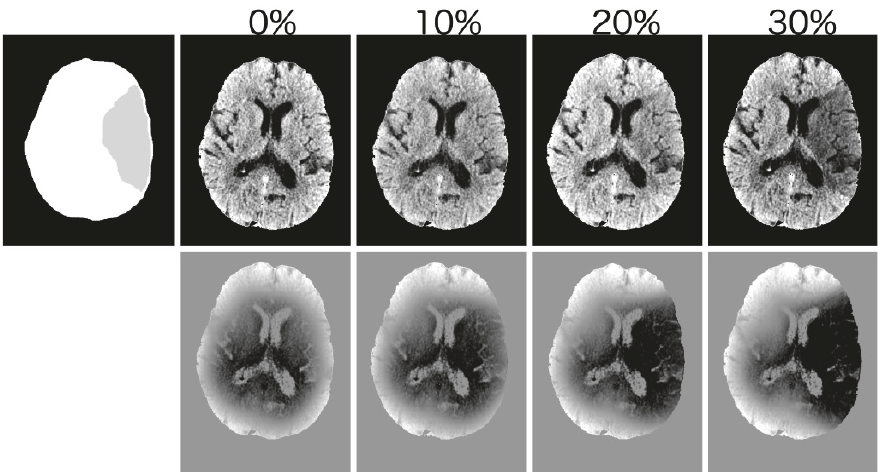
Figure 2: Simulated MCA territory infarcts. The figure illustrates the visual appearance of simulated MCA-territory infarcts of various (known) attenuations (top) and the appearance of each known attenuation on the difference map (bottom). The simulated territory is shown top-left for reference. Infarcts of less than 20% decreased density show poor margin